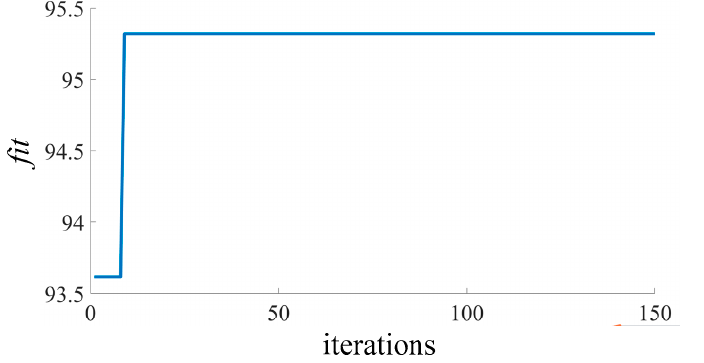
Figure 11. Iterative calculation process of main pump state identification based on EEMD-OQGA- SVM algorithm.